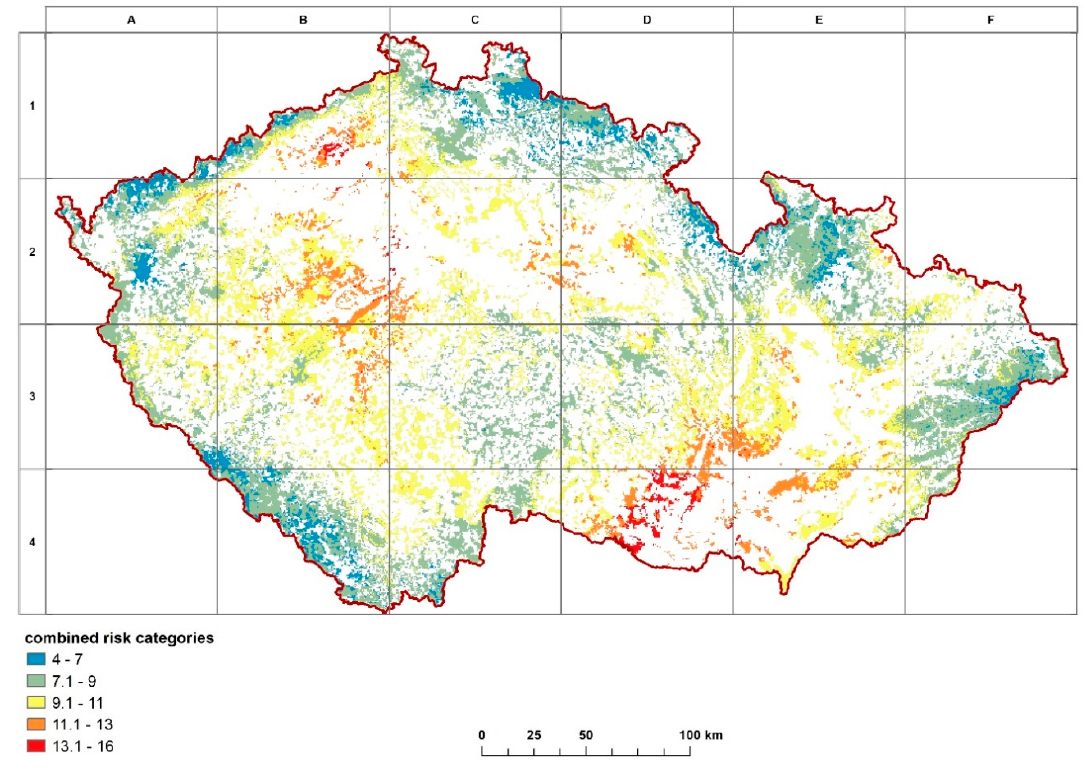
Figure 6. Percentage/area of categories of the case study area.